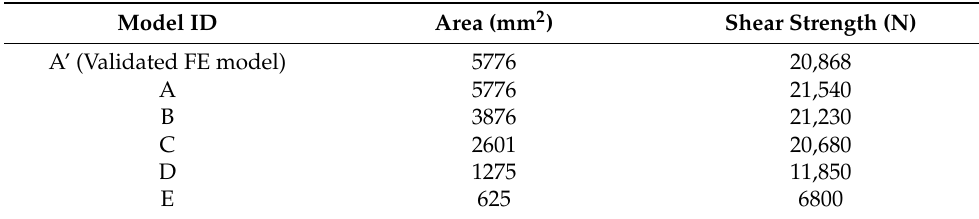
Table 7. Shear strength various GFRP bonded areas.